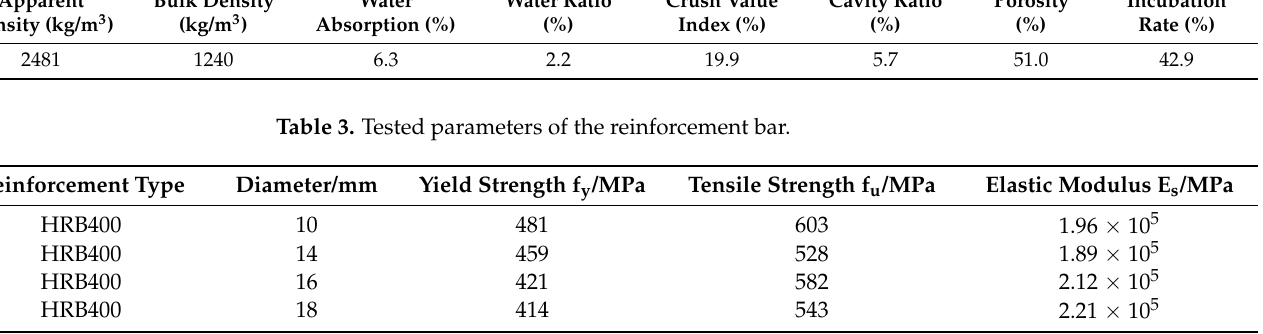
Table 4. Mix proportion design of recycled aggregate